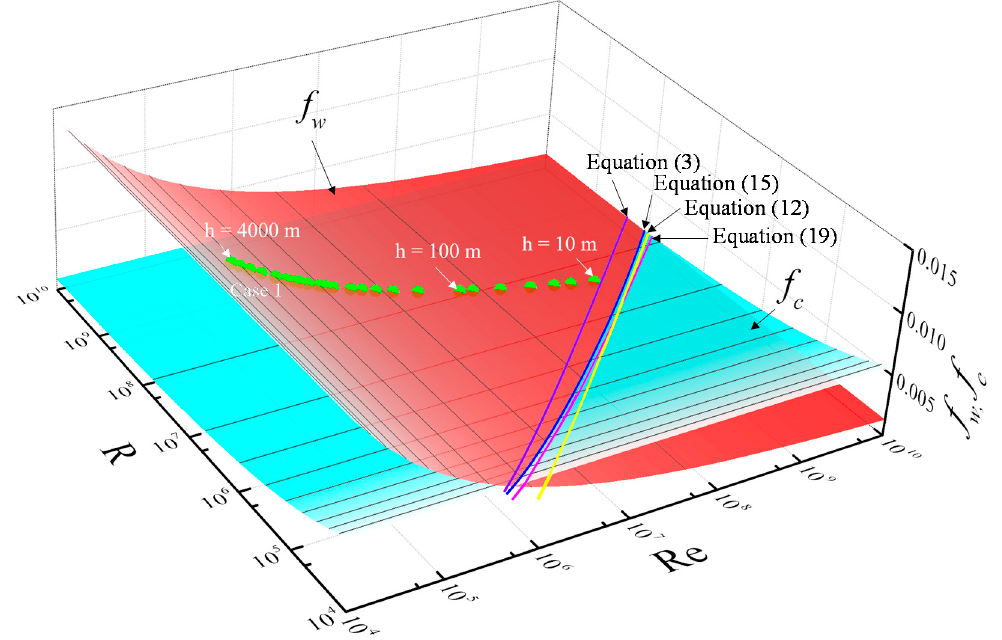
Figure 2. 3D view of friction factors, Equations (3), (12), (15), and (19), and a hypothetical shoaling tsunami (Case 1). Again, Equation (19) is further modified so that the demarcation is expressed in term of Re δ and h / δ s